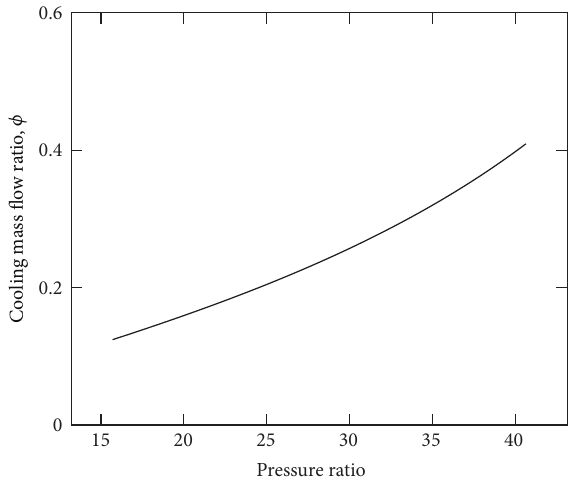
Figure 5: Cooling mass flow ratio as function of pressure ratio for the reference